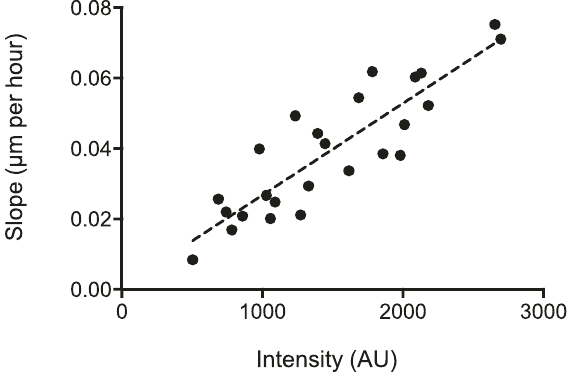
Fig. 9 The concentration of mHtt particles is directly proportional to the concentration of soluble mHtt. The growth rate of the radius of 25 individual inclusion bodies (IBs) (slope of the best- fi t line) is plotted vs the intensity of the cytoplasm in which the IB was found. The distribution is fi tted with a line ( R 2 =